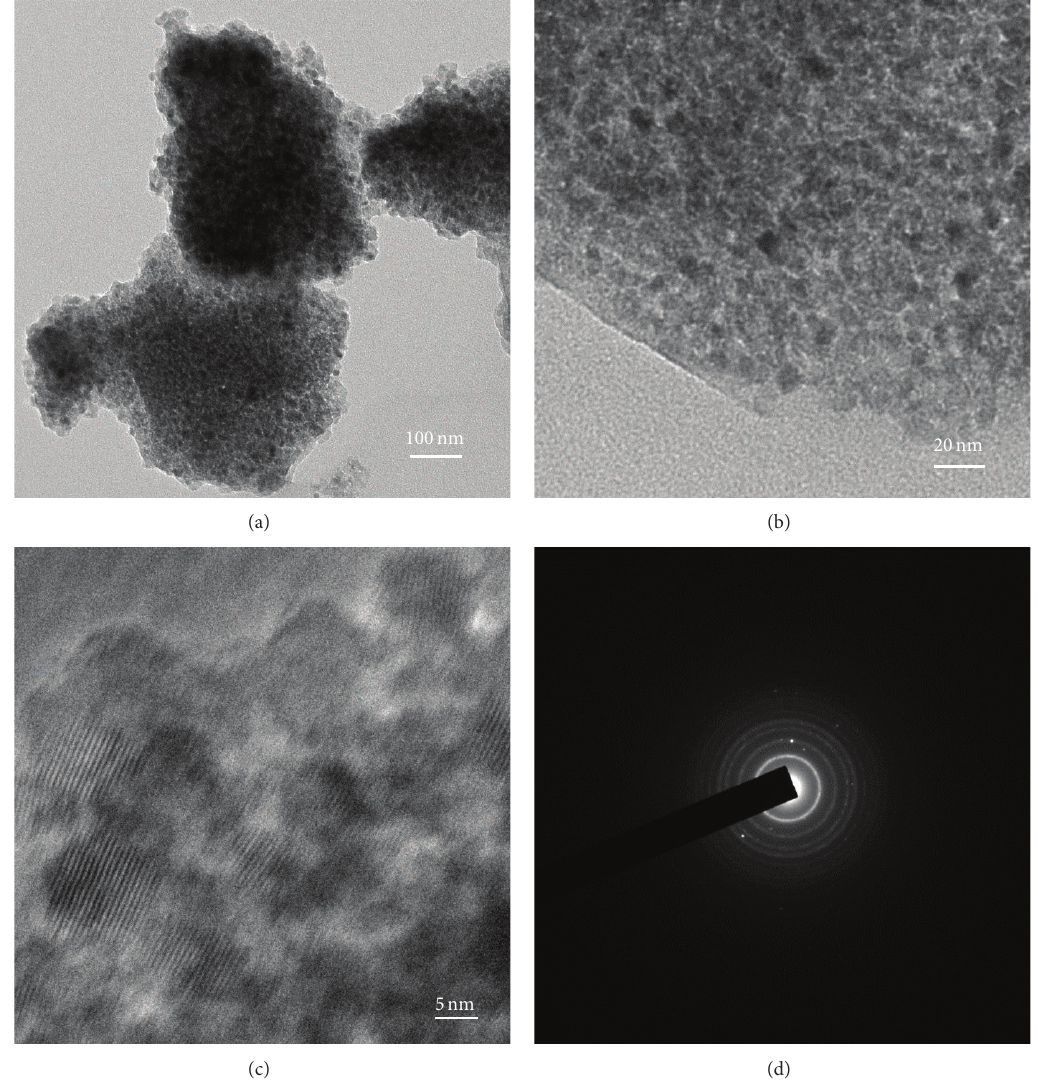
Figure 4: TEM ((a) and (b)), HRTEM (c) images, and ED (d) of MTiO 2